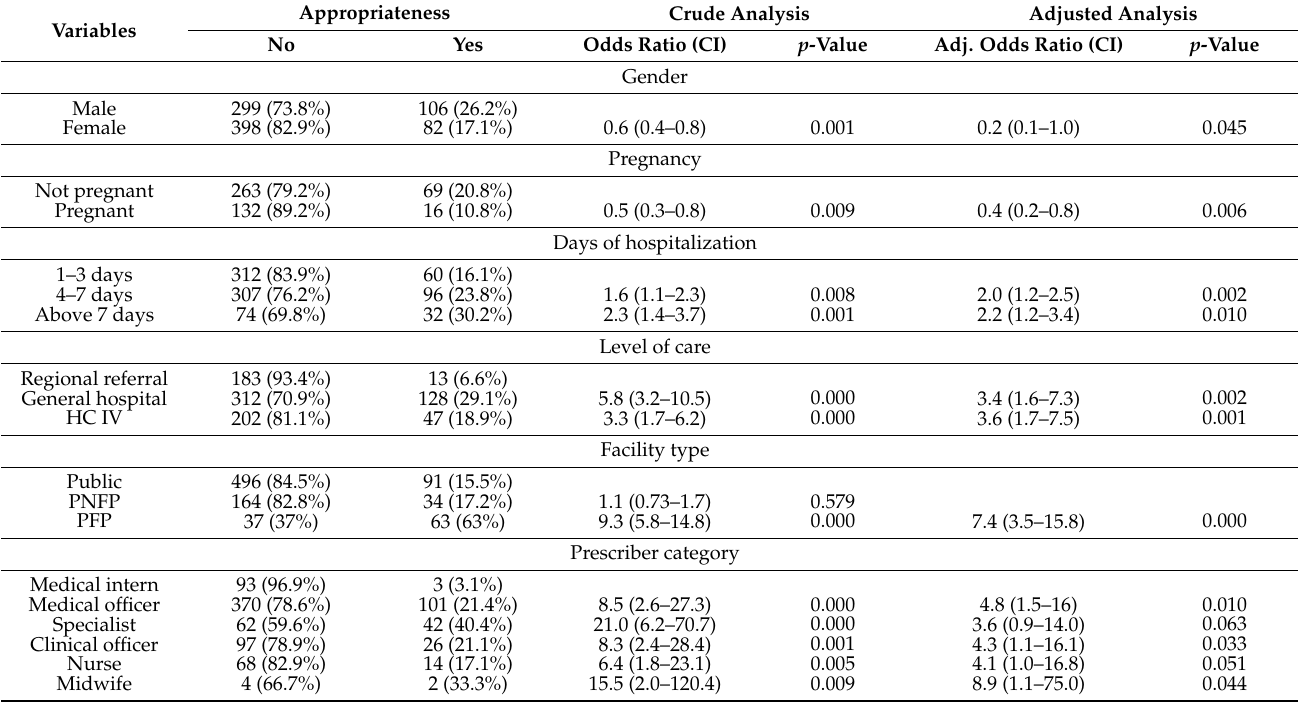
Table 6. Factors associated with appropriate use of ceftriaxone using bivariate and multivariate logistic regression.